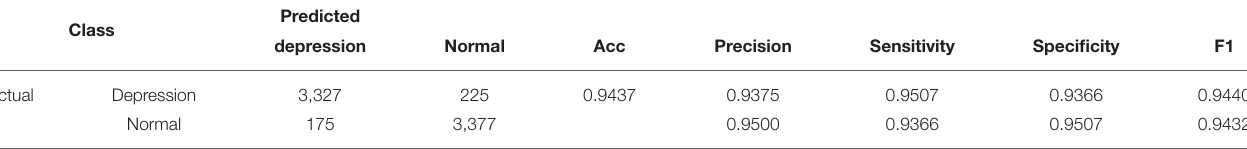
TABLE 3 | Performance values obtained when testing the SparNet model using EEG